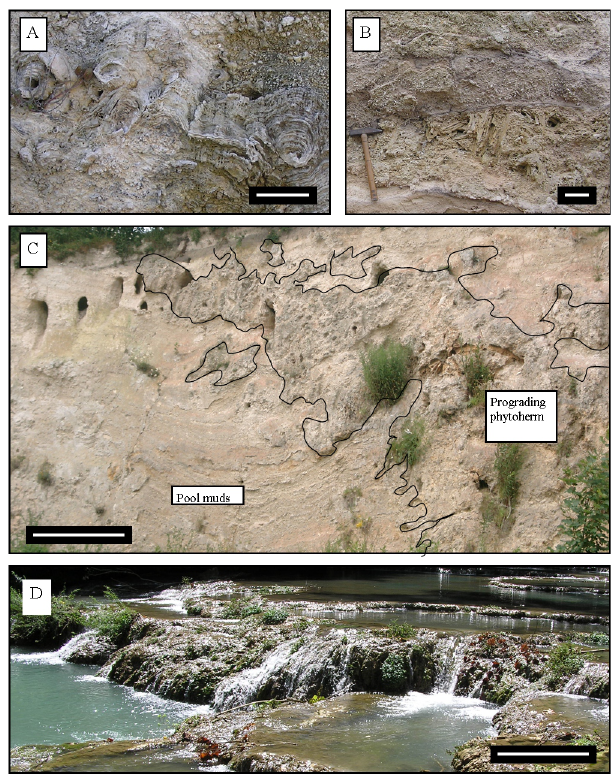
Figure 7. Low temperature, low ∆ G r . (A) Stromatolite microherm development in a fluvial tufa. Scale bar is 50mm long. Early Qua- ternary Noto tufa, Sicily, Italy. (B) Burr reed Phytoherm cushion in- terlayered with detrital tufas above and lacustrine lime muds below. Scale bar is 150mm long. Holocene Caerwys tufa, North Wales. (C) Profile view of a prograding phytoherm framestone sandwiched be- tween adjacent lime mud pool deposits. Scale bar is 150mm long. Holocene Caerwys tufa, North Wales. (D) An active pool and bar- rage system forming in Tuscany (cf. 2C). Scale bar is 1m long. Colle val d’Elsa,